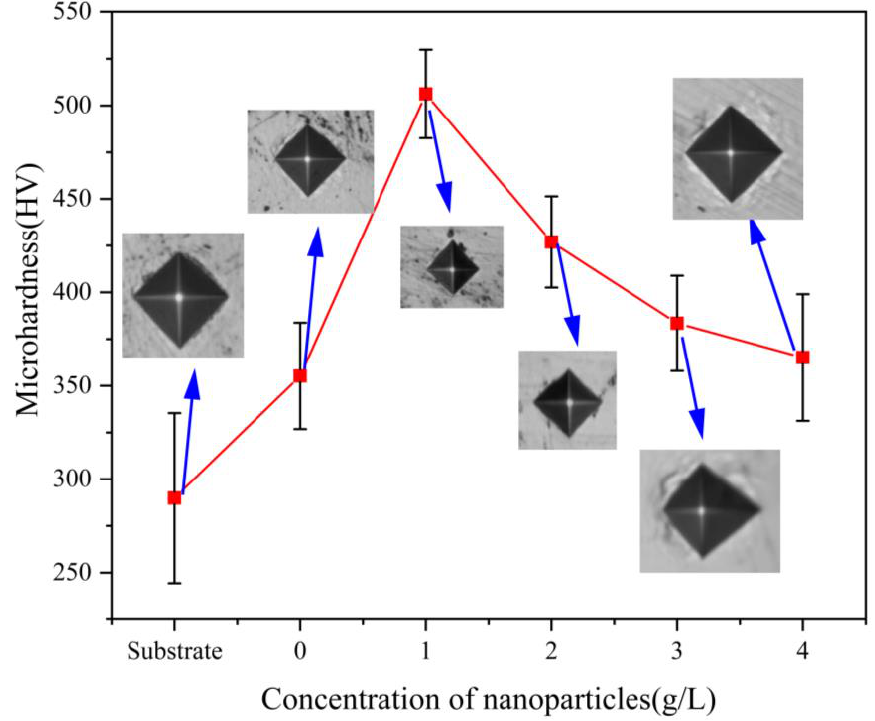
Figure 6. Relationship between the hardness of the composite coating and nanoparticle concentration.